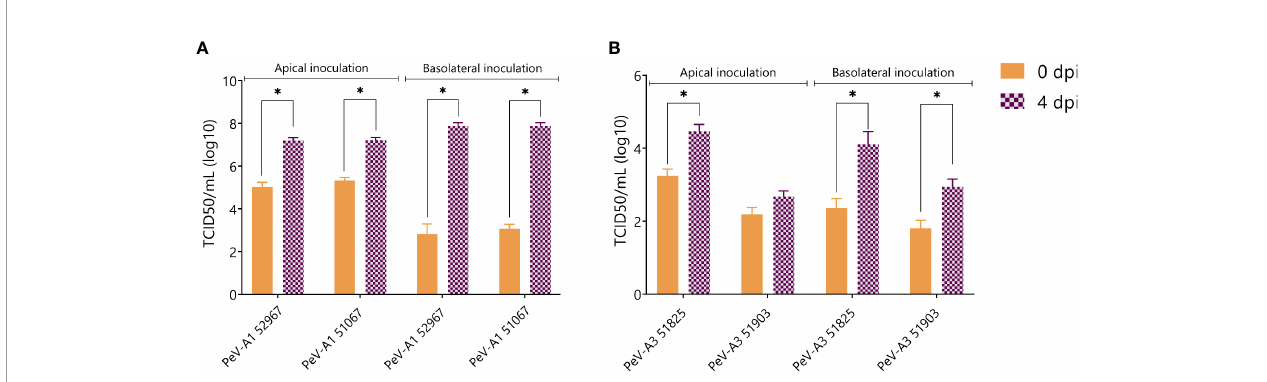
FIGURE 5 | Virus titer at 0 and 4 days post infection of apically collected samples for (A) PeV-A1 clinical isolates and (B) PeV-A3 clinical isolates. Titers were determined by TCID50. In all cases, data represent the mean ± SEM of two technical replicates in three biological replicates. * p -value < 0.05. dpi = days post infection.